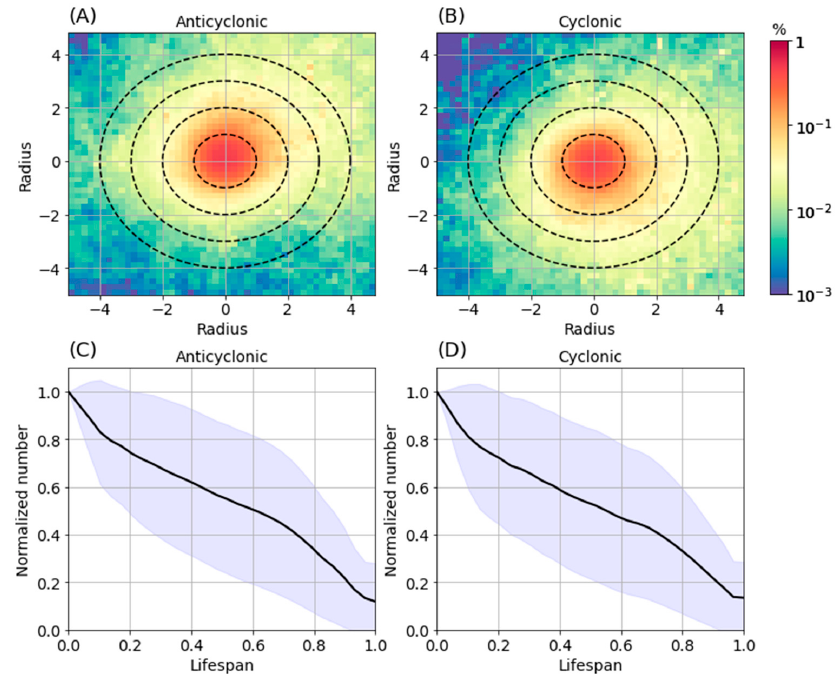
Figure 7. ( A , B ) Spatial distributions of 𝑄 at the final time and ( C , D ) leakage trends during the normalized lifespan for anticyclonic (left panels) and cyclonic (right panels) eddies. Color shading in ( C ) and ( D ) represents one standard deviation of the mean over all samples.